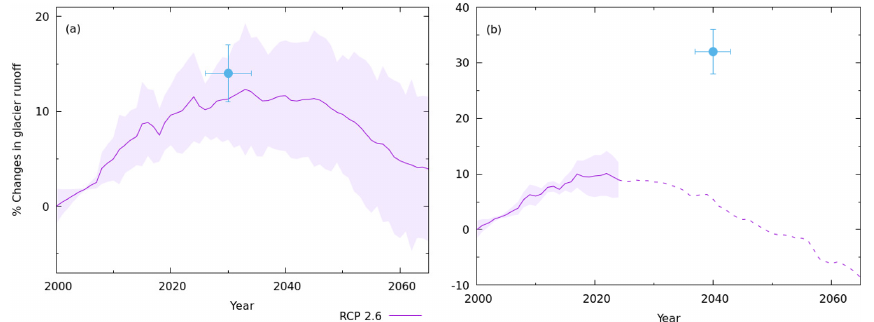
Figure 9. The “peak water” due to future glacier changes predicted using Eq. (15) for (a) Chandra, and (b) upper Dudhkoshi catchments, respectively. The solid sky-blue dots represents the corresponding “peak water” as reported in Huss and Hock (2018) for both catchments. The dashed portion of the solid line in the upper Dudhkoshi catchment indicates the corresponding temperature change beyond the calibration range of the catchment. See text for